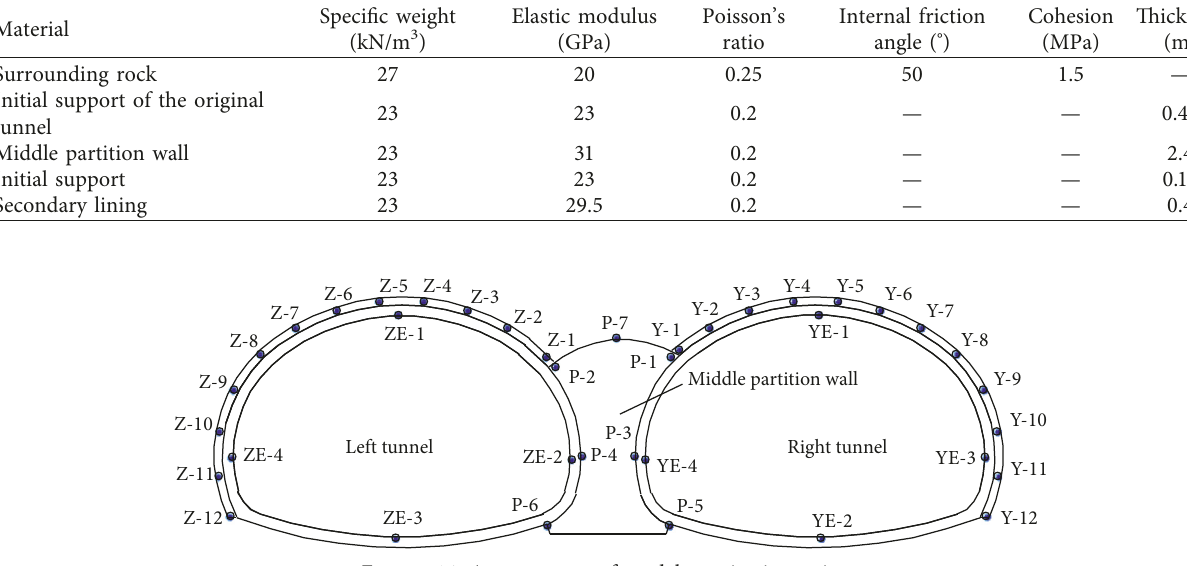
Figure 14: Arrangement of model monitoring points.